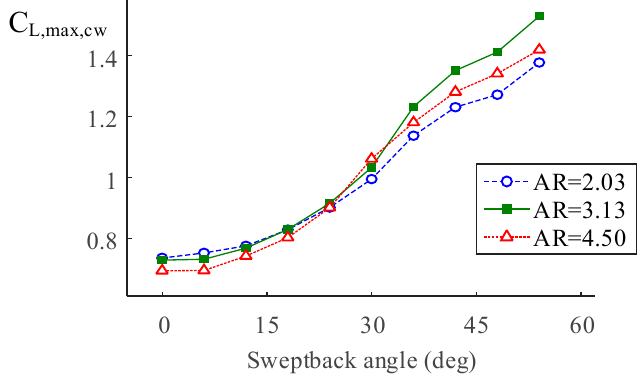
Figure 8. Maximum C L,cw with respect to β .